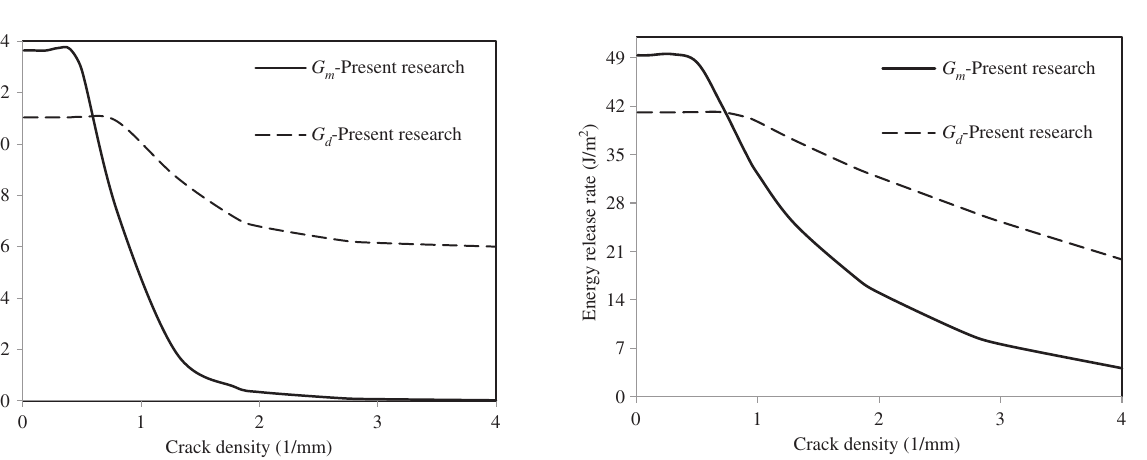
] s carbon/ 2 = 10 MPa. 2